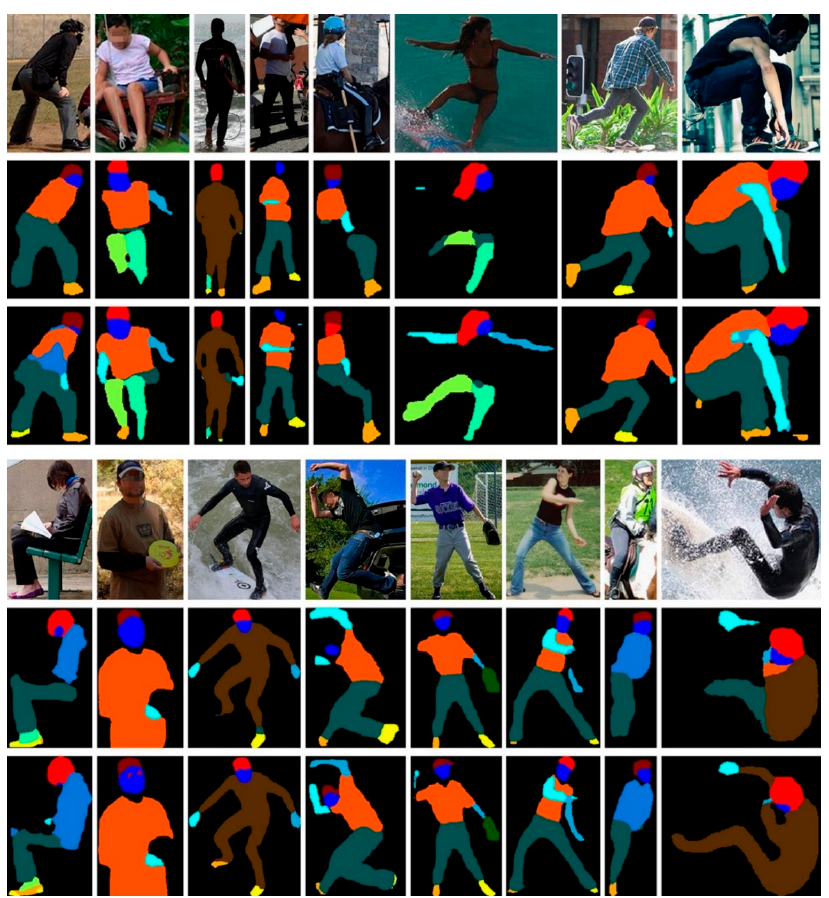
Figure 9. Performance comparison between the OM and the SM on the test set. From the top row to the bottom row are input images, predictions from the SM and predictions from the OM.